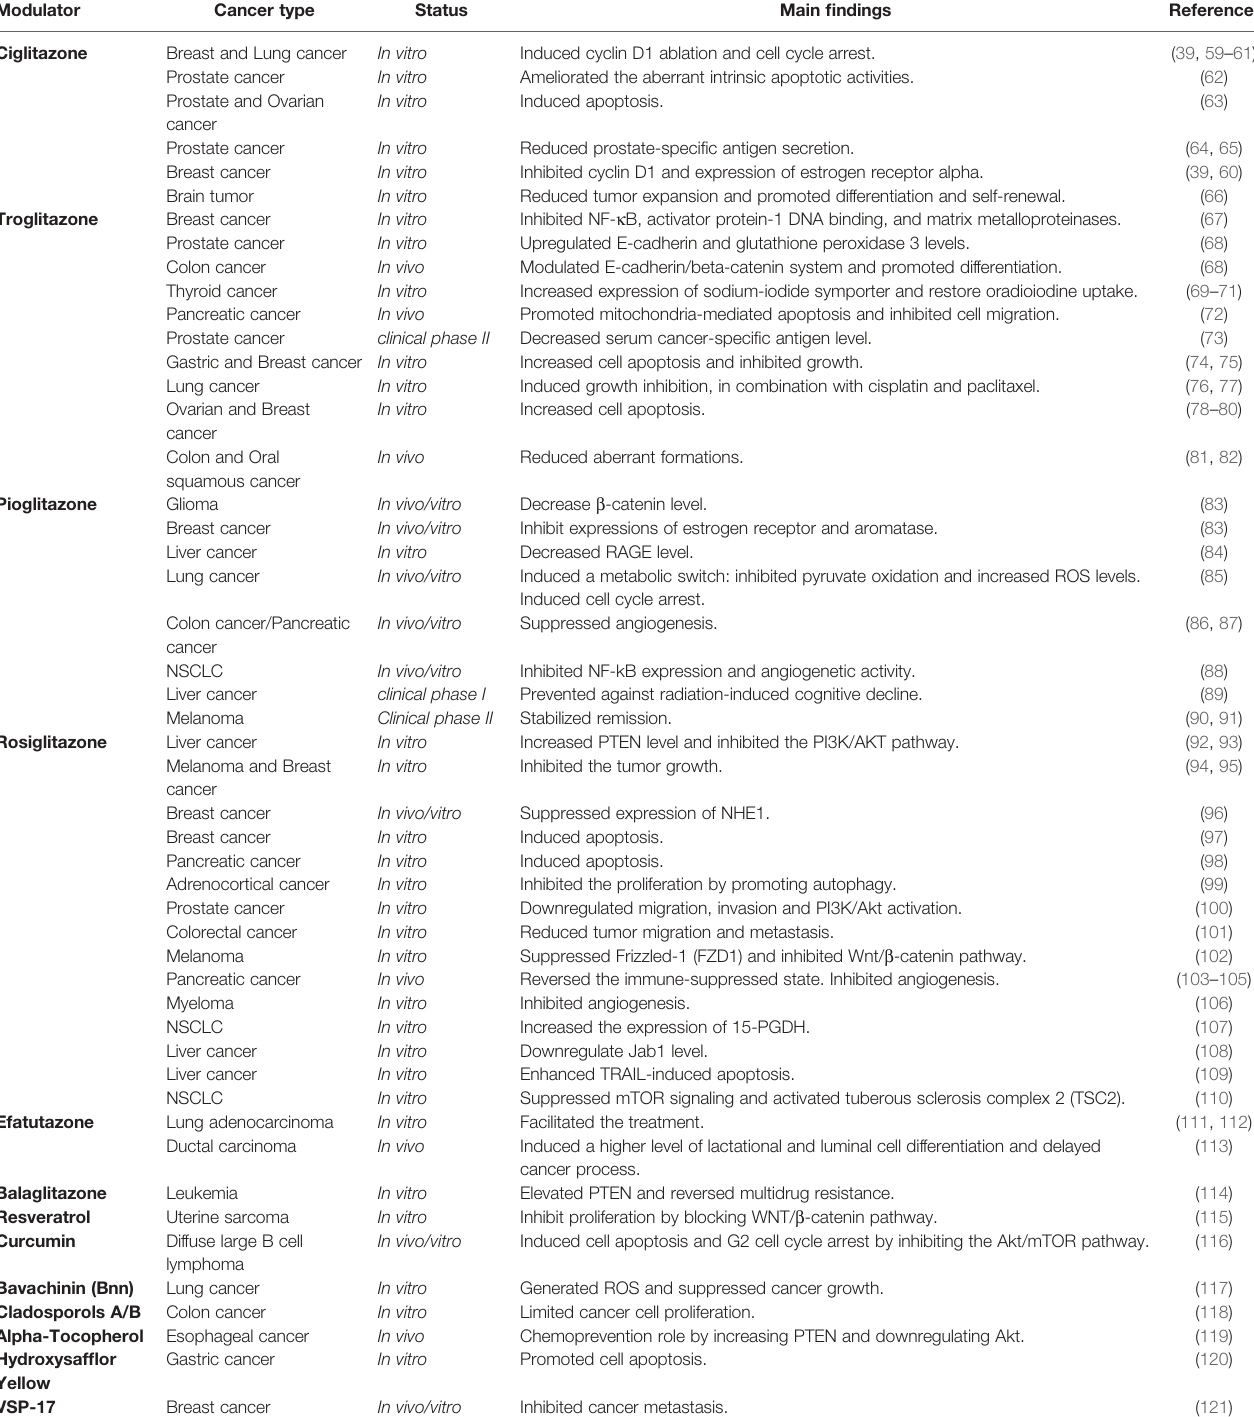
TABLE 1 | Summary of the PPAR- g modulator in different types of cancer.